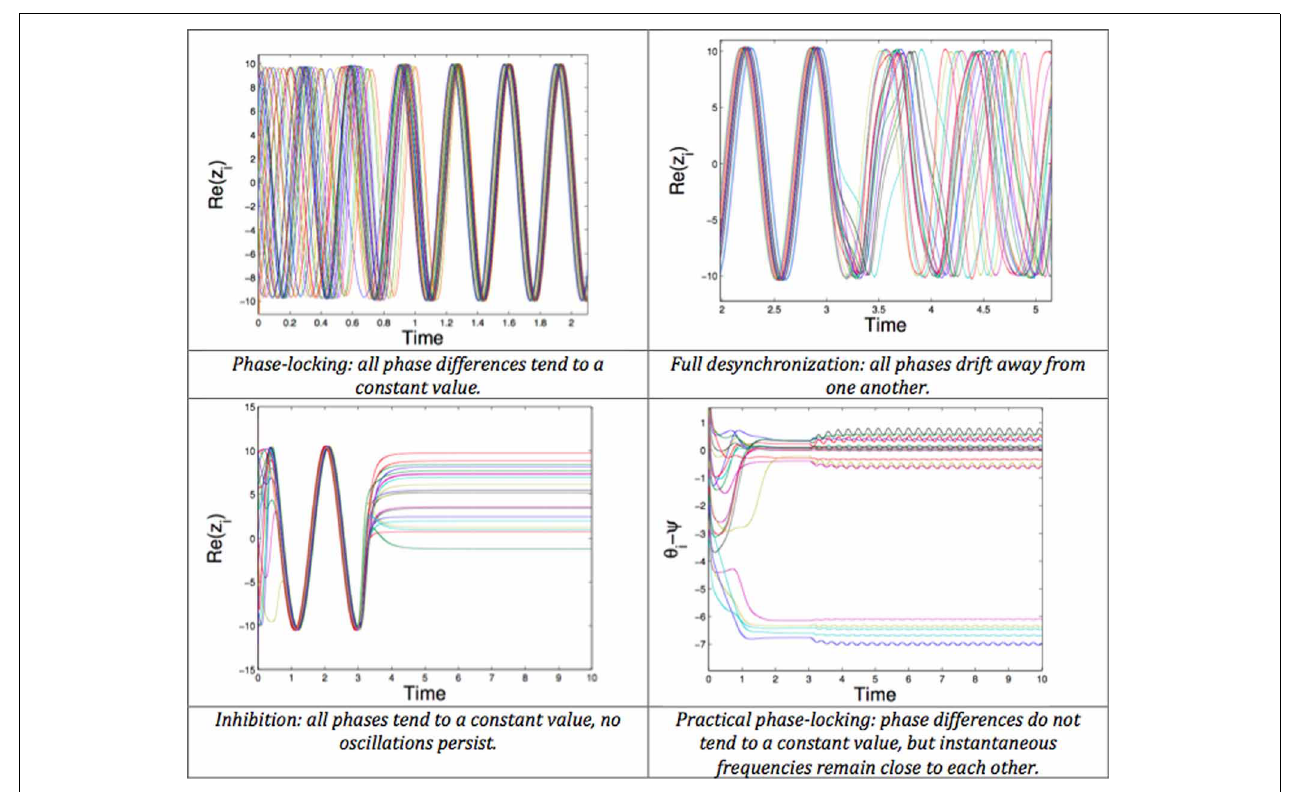
FIGURE 8 | Possible behaviors of a network of phase oscillators. Top left: Phase-locking (all phase differences tend to a constant value). Top right: Full desynchronization (all phases drift away from one another). Bottom left: